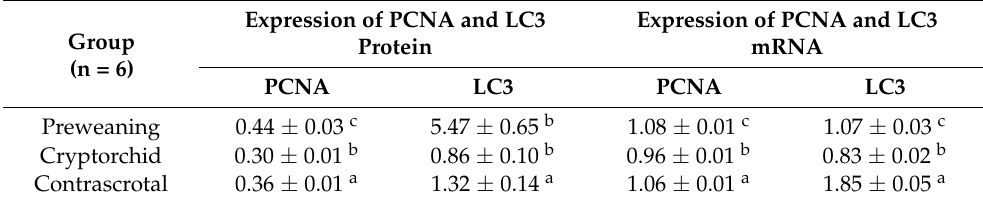
Figure 7. Western blot analysis for PCNA and LC3 protein in boar testes. GAPDH was used as an internal control. Western blot results of PCNA and LC3 in preweaning, cryptorchid, and contrascrotal testes ( A ). The histograms represent the densitometric values of the immunoblots, ( B ) and ( C ). 1, preweaning; 2, cryptorchid; 3, contrascrotal. ** p < 0.01, *** p < 0.001. Table 3. Expression of PCNA and LC3 proteins and mRNA in preweaning, cryptorchid, and con- trascrotal, respectively. The results represent mean ±SD.